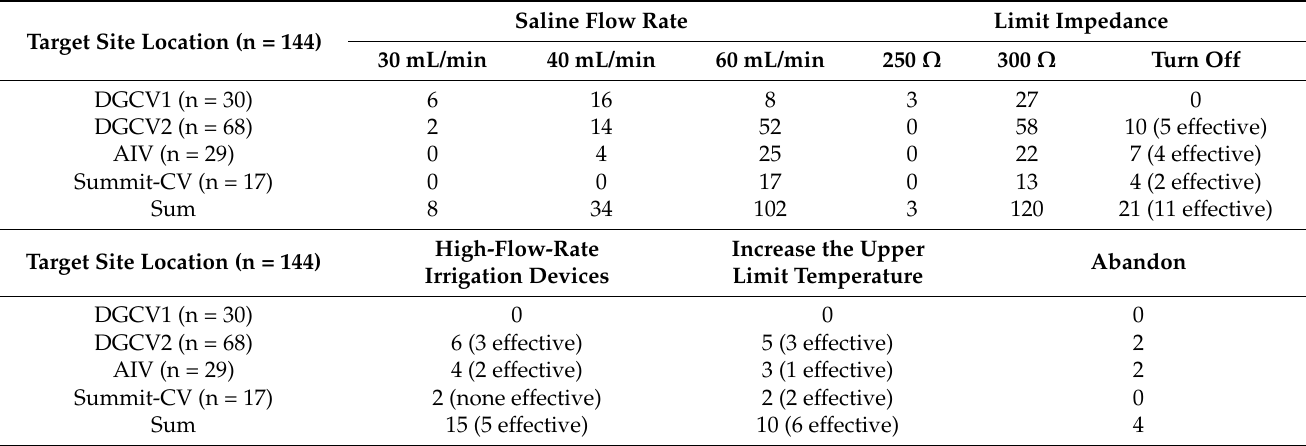
Table 2. The details of the ablation strategies used in different target site locations (cases).